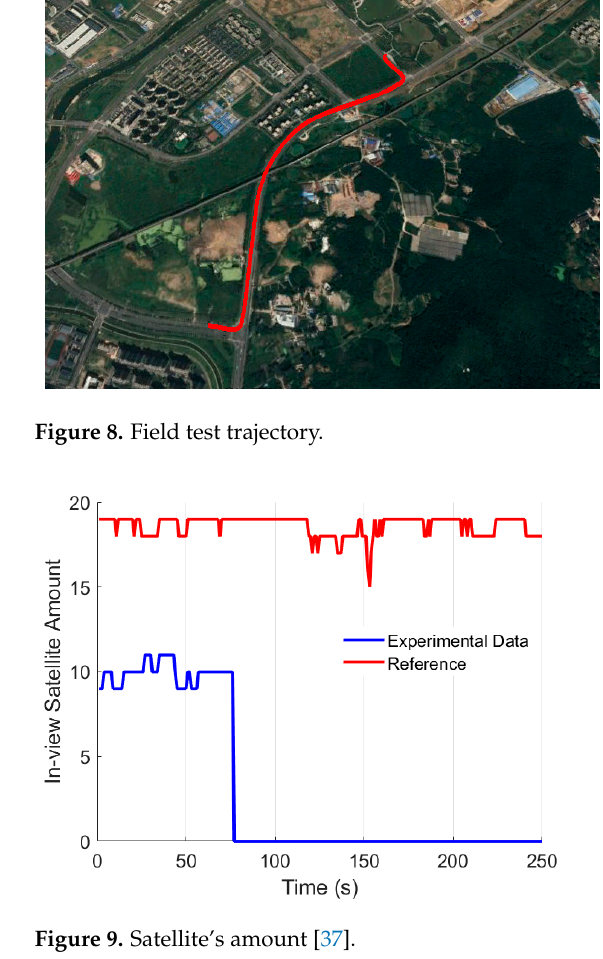
Figure 7. Position errors distribution. ( a ) East-position errors distribution. ( b ) North-position er- rors distribution. ( c ) Horizontal-position errors distribution.